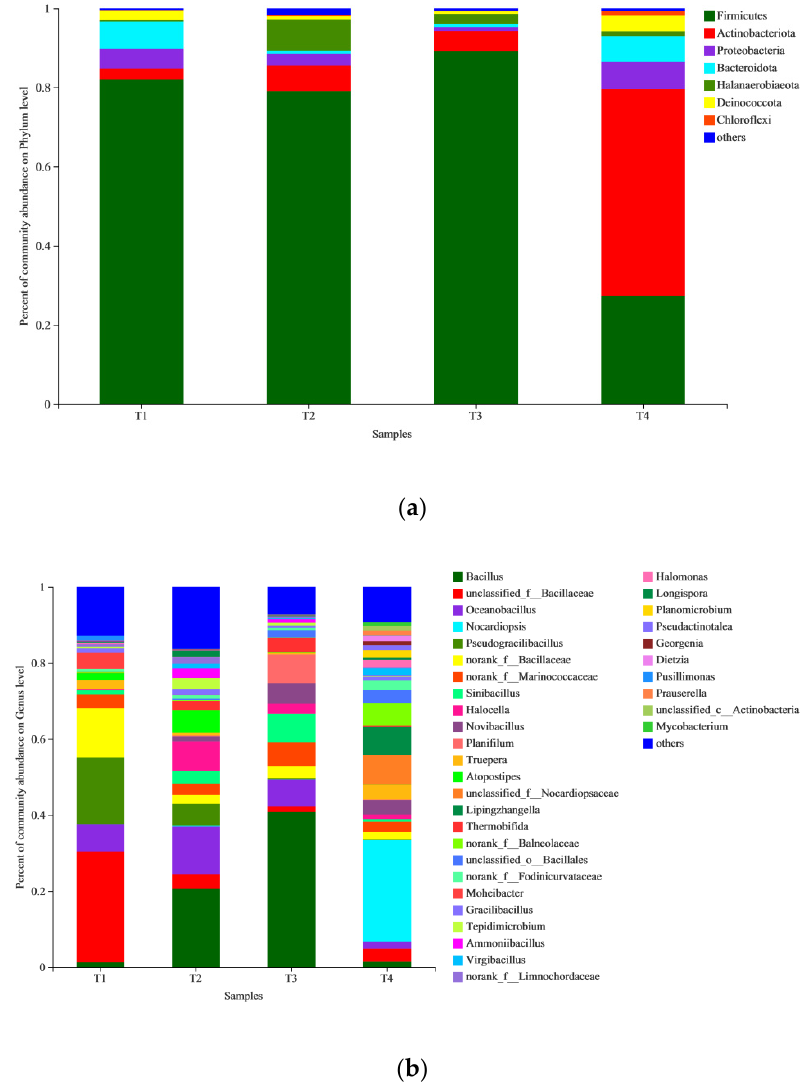
Figure 3. ( a ) A diagram of relative bacterial abundance at phylum level. Phyla with relative abun- dance < 1% were combined and indicated as “others”. ( b ) A diagram of relative bacterial abundance at genus level. Genera with relative abundance < 1% were combined and indicated as “others”.